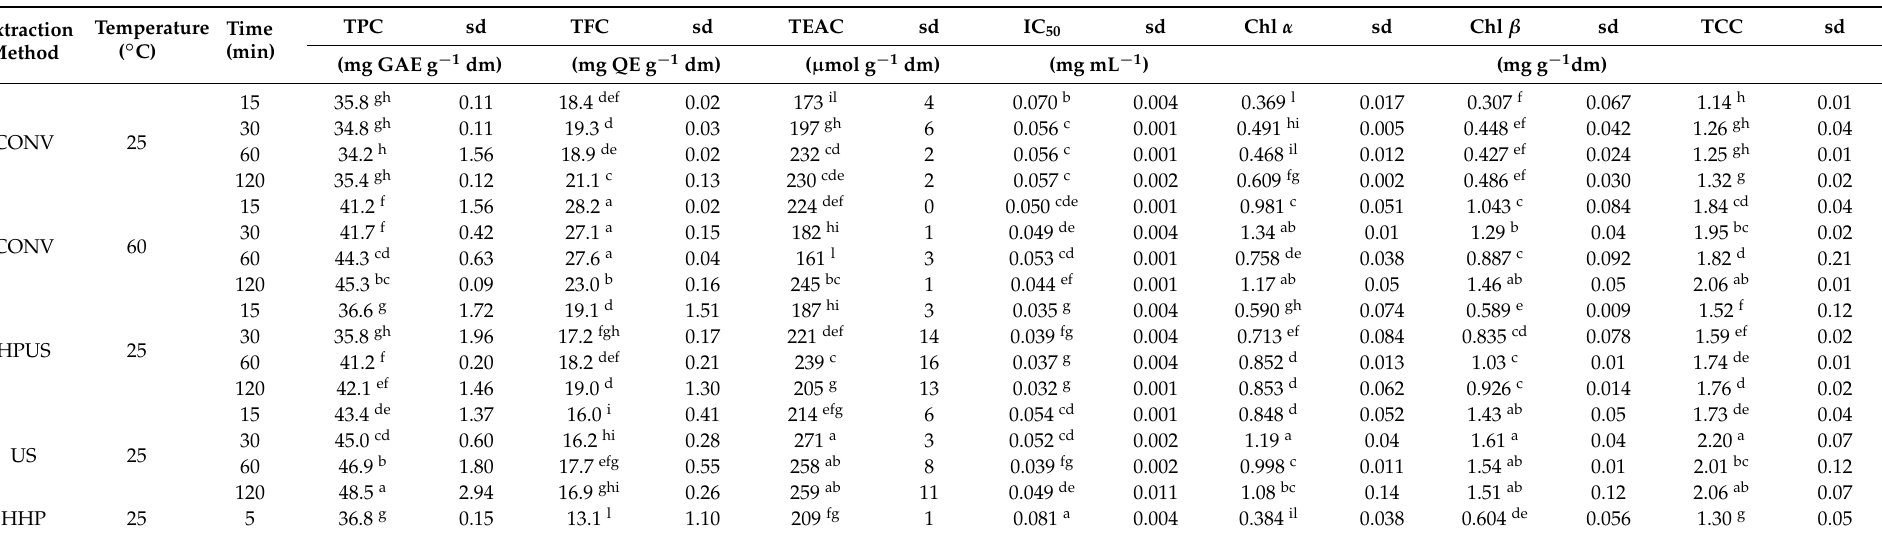
Table 2. Functional properties of different food grade hop